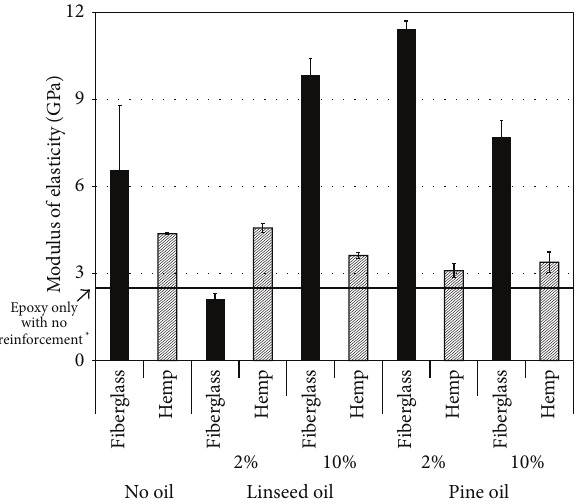
Figure 1: Tensile strength for epoxy composites with and without oil addition. ∗ Data taken from TAP Plastics product bulletin [21].